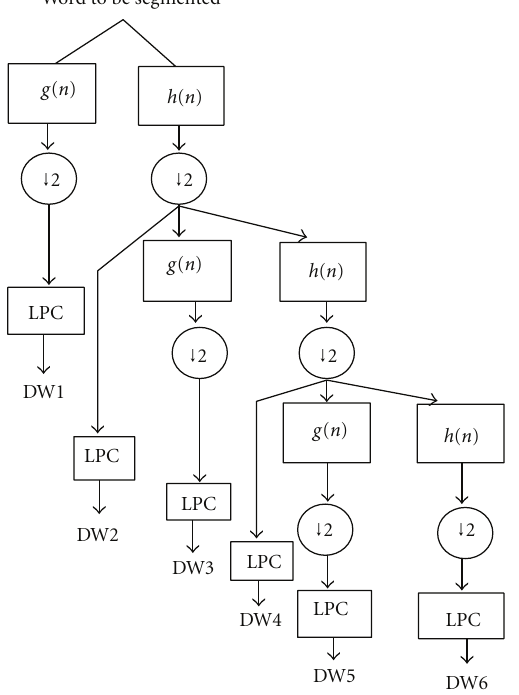
Figure 1: DWT segmentation